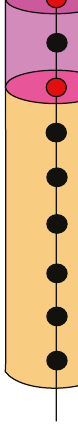
Figure 8: Schematic view of the solution to the gap problem. Dur- ing the tracing, critical voxels are detected (red). In a subsequent pass, di ff erent fibers containing the same critical voxels are merged into a single